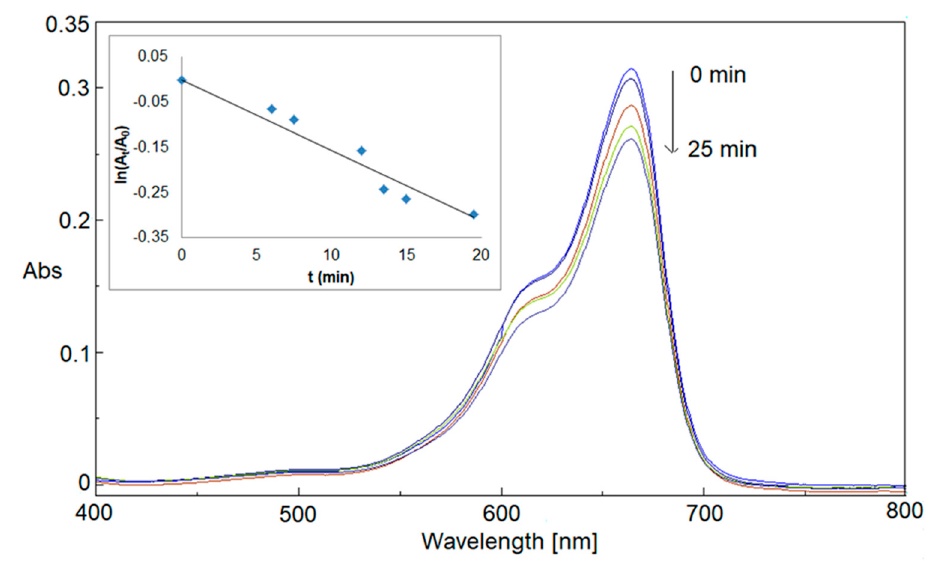
Figure 5. Catalytic reduction of MB by NaBH 4 (reference).